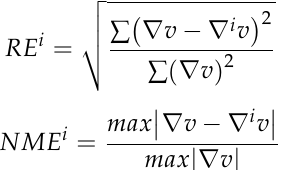
Table 1. All of the possible TCRE configurations for the outer radius of the outer ring equal to 6.